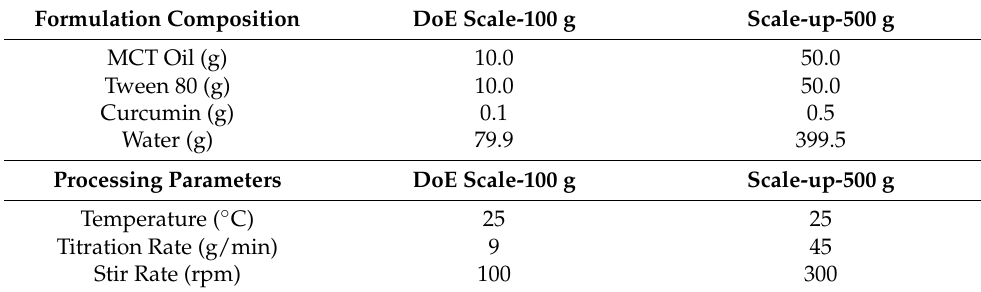
Table 4. CUR-loaded nanoemulsion and scale-up: Formulations and processing parameters.